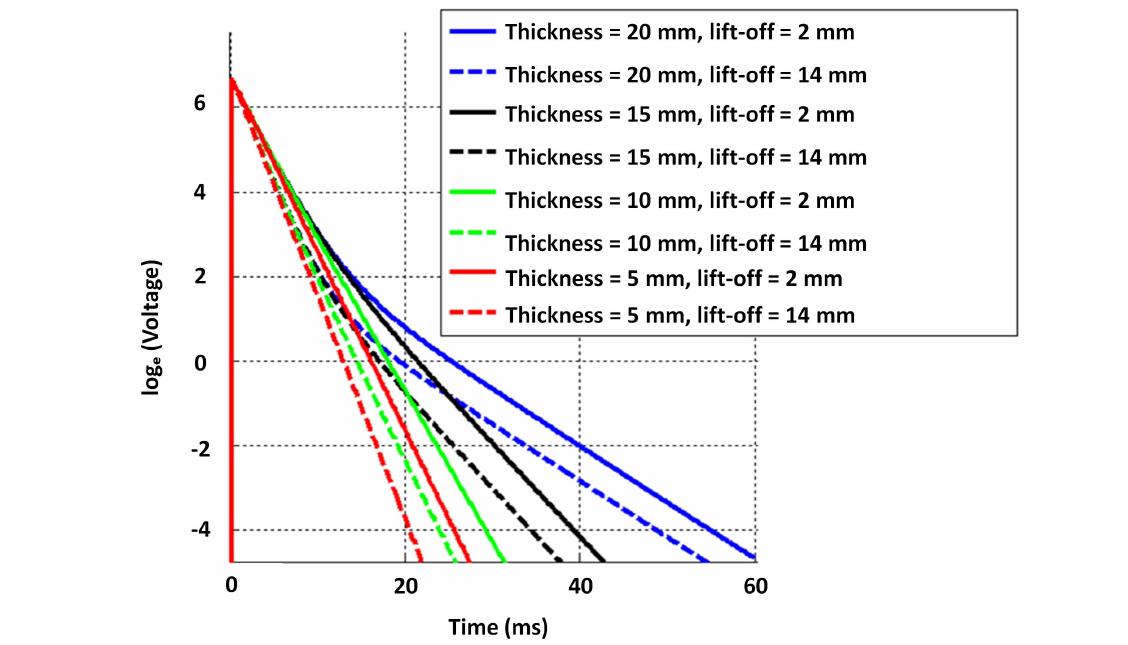
Figure 7. Numerically-simulated signals by the 2D axisymmetric model for different grey cast iron thickness with and without lift-off (visualized as ln [ V ( t )] ); sharp rising edges of signals are not discriminable in the ms time scale and appear to be